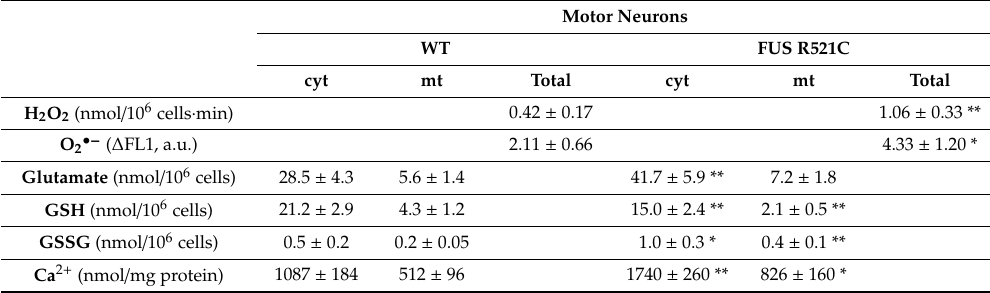
Table 1. ROS generation and levels of glutamate, GSH, GSSG and Ca 2 + in motor neurons isolated from wild-type (WT) and FUS R521C